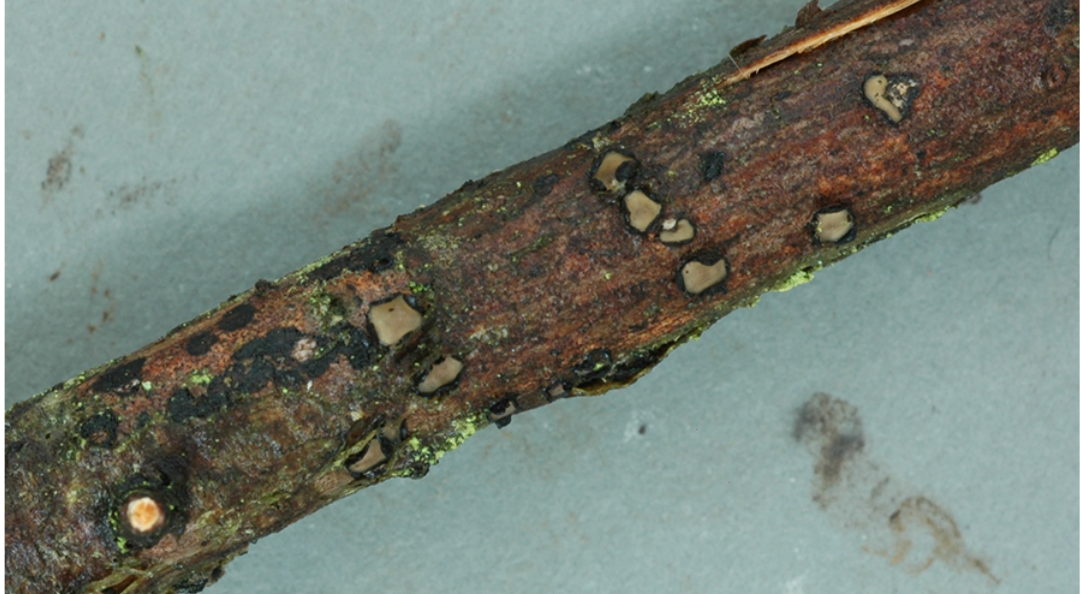
Fig. 1 Ascomata of Colpoma juniperi (P. Karst. ex P. Karst.) Dennis from Kampinos National Park (2018-09-09). Photography by Błażej